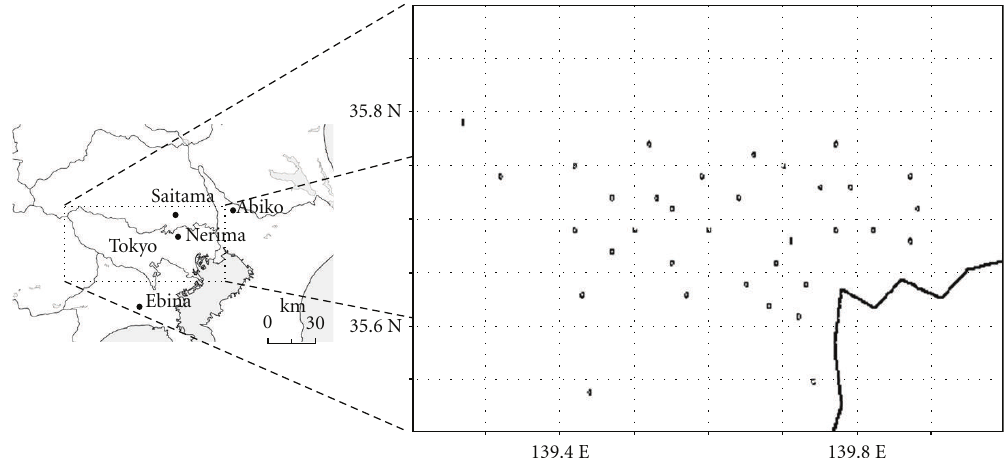
Figure 8: Monitoring stations used for validation of the CMAQ model and locations of the 34 environmental monitoring stations in the Tokyo